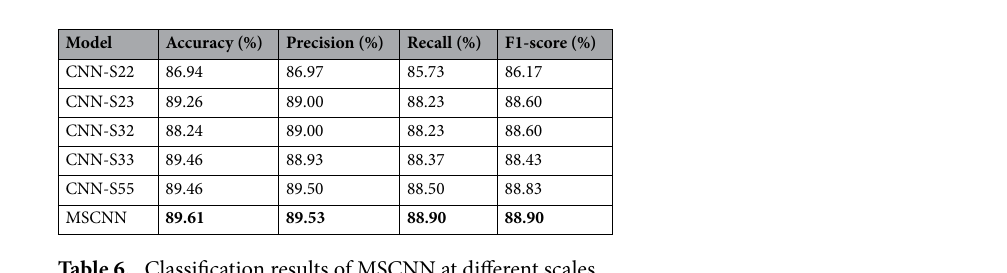
Table 6. Classification results of MSCNN at different scales.